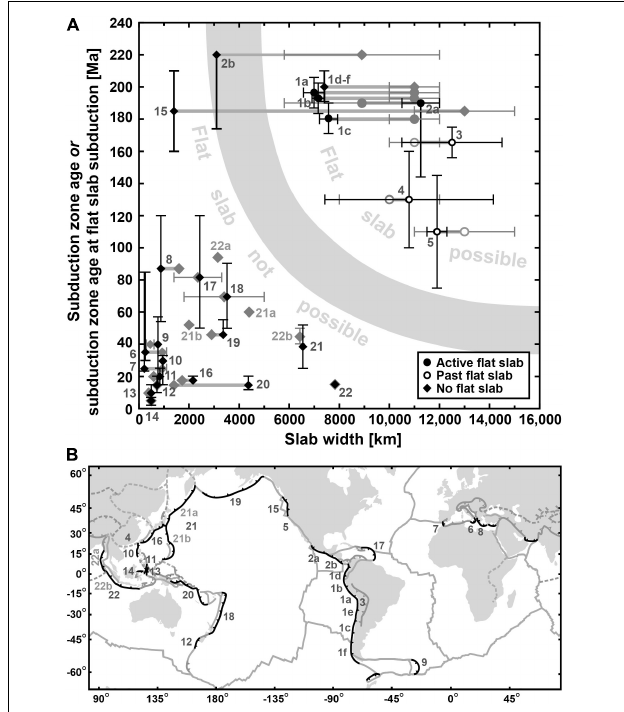
FIGURE 2 | (A) Diagram showing the dependence of flat slab subduction in nature on slab width (trench-parallel extent) and subduction zone age. Diamonds represent subduction zones/segments without a flat slab. Filled circles and white circles with an outline represent subduction zones with a present-day flat slab and flat slab in the geological past, respectively. For the black circles and white circles with black outline subduction zone age and slab width represent the age and width at the time of flat slab inception. For the black diamonds subduction zone age and slab width represents their age and width at present. For the gray circles, white circles with a gray outline and gray diamonds slab width represents the width at subduction initiation. See Appendix and Tables 1 , 2 for data choices, justification and uncertainties. Black bars and gray bars are not error bars but indicate range of age estimates and slab width estimates, where data point location represents the average or the best estimate (see Appendix and Tables 1 , 2 ). Thick horizontal gray lines connect subduction initiation data point with present-day subduction zone data point (diamonds) or flat slab subduction initiation data point (circles) of the same subduction zone (segment). Subduction zone data points: 1–South America with 1a–Southern Peru segment (Nazca ridge),